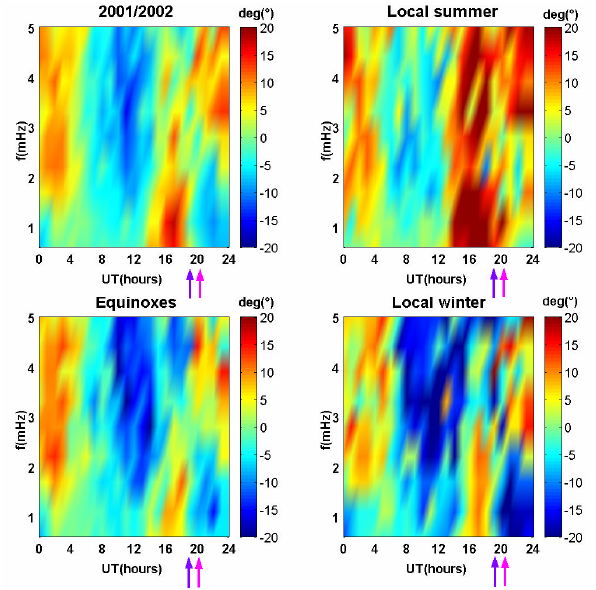
Fig. 4. Daily distribution of the average phase difference between the two stations for: (a) the whole 2-years interval, (b) local sum- mer, (c) equinoxes, (d) local winter; the phase difference is positive (negative) for SBA (TNB) leading, i.e. for geomagnetic fluctuations propagating westward (eastward). Pink and violet arrows indicate local geomagnetic noon at TNB and SBA, respectively.